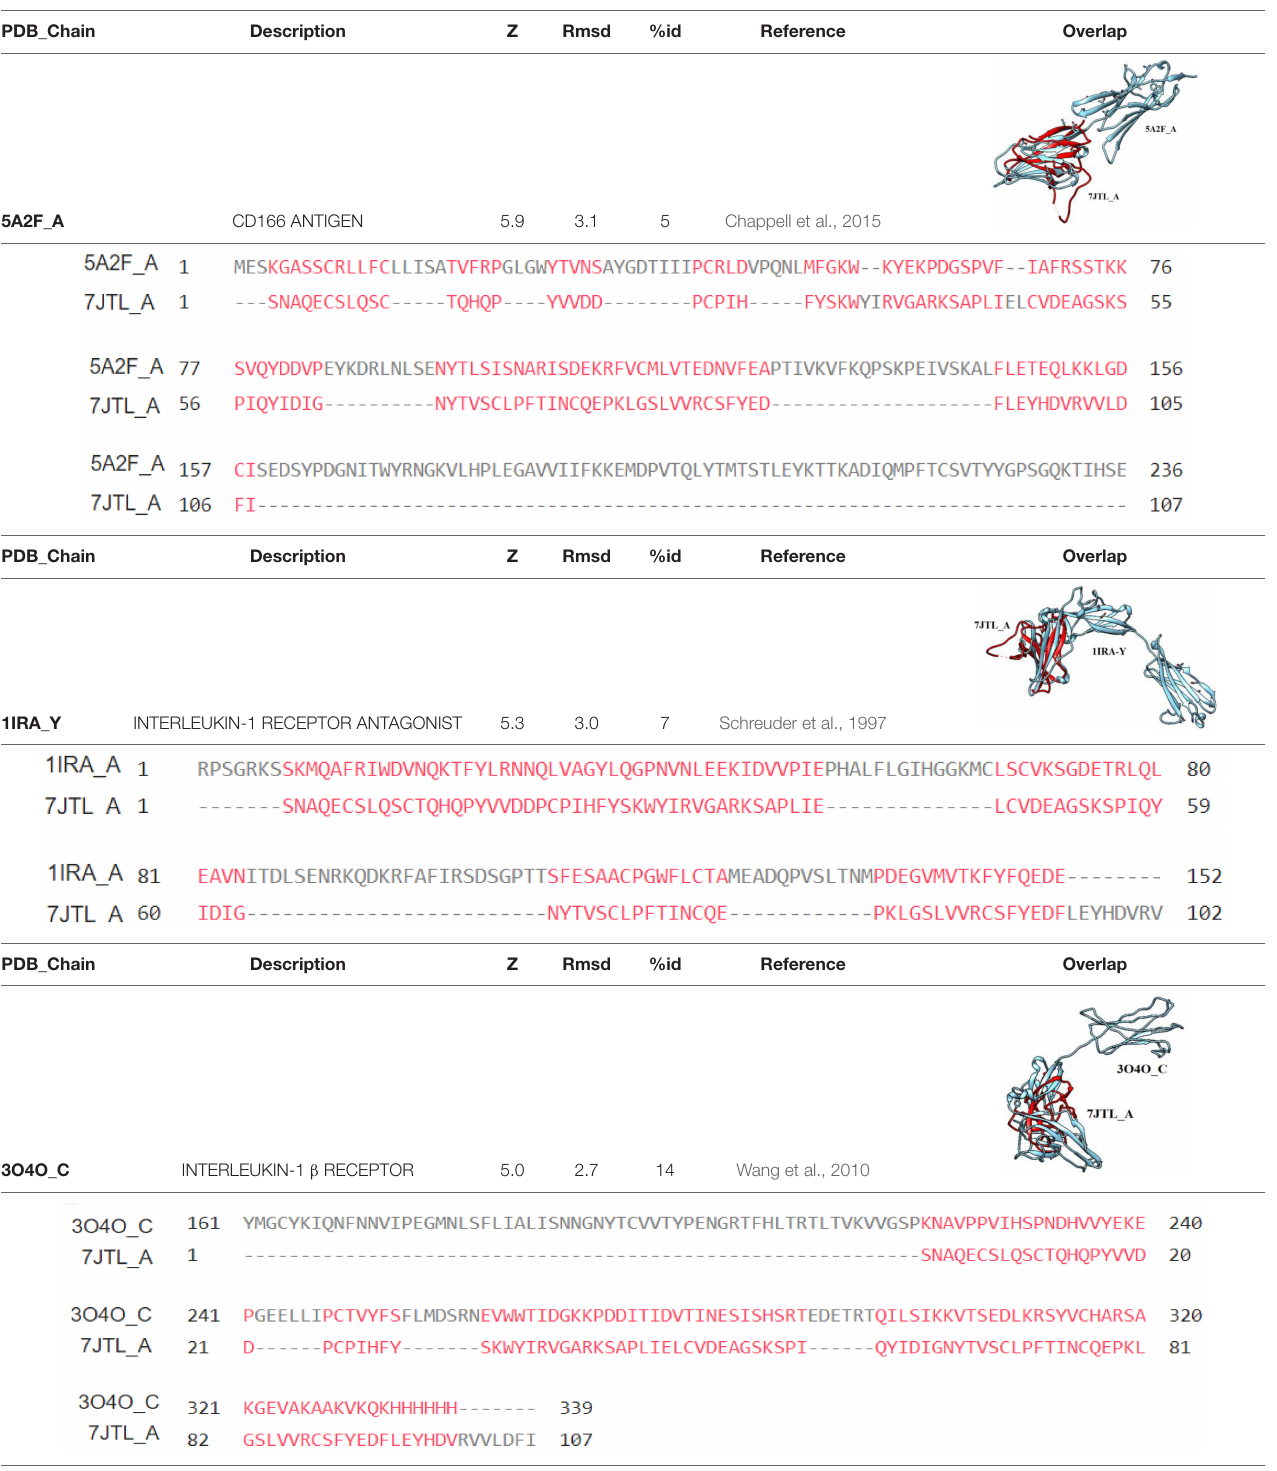
TABLE 1 | Highlights of PDB 7JTL comparative studies using dali